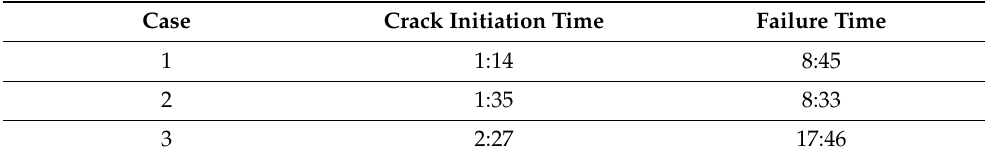
Table 4. Calculation time statistics of three